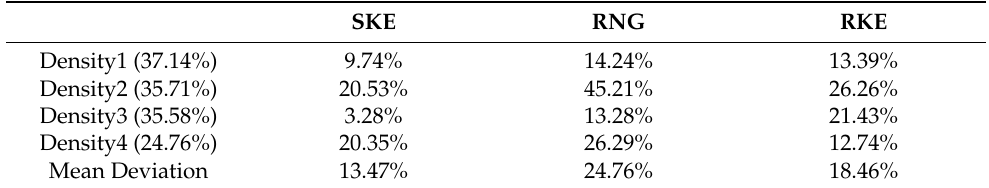
Figure 10. SKE-, RNG-, and RKE-simulated wind environment distribution at point 13. ( a ) SKE-simulated wind environment distribution at point 13. ( b ) RNG-simulated wind environment distribution at point 13. ( c ) RKE-simulated wind environment distribution at the point. Table 2. The deviation between the measured and simulated average wind speed for different building densities.